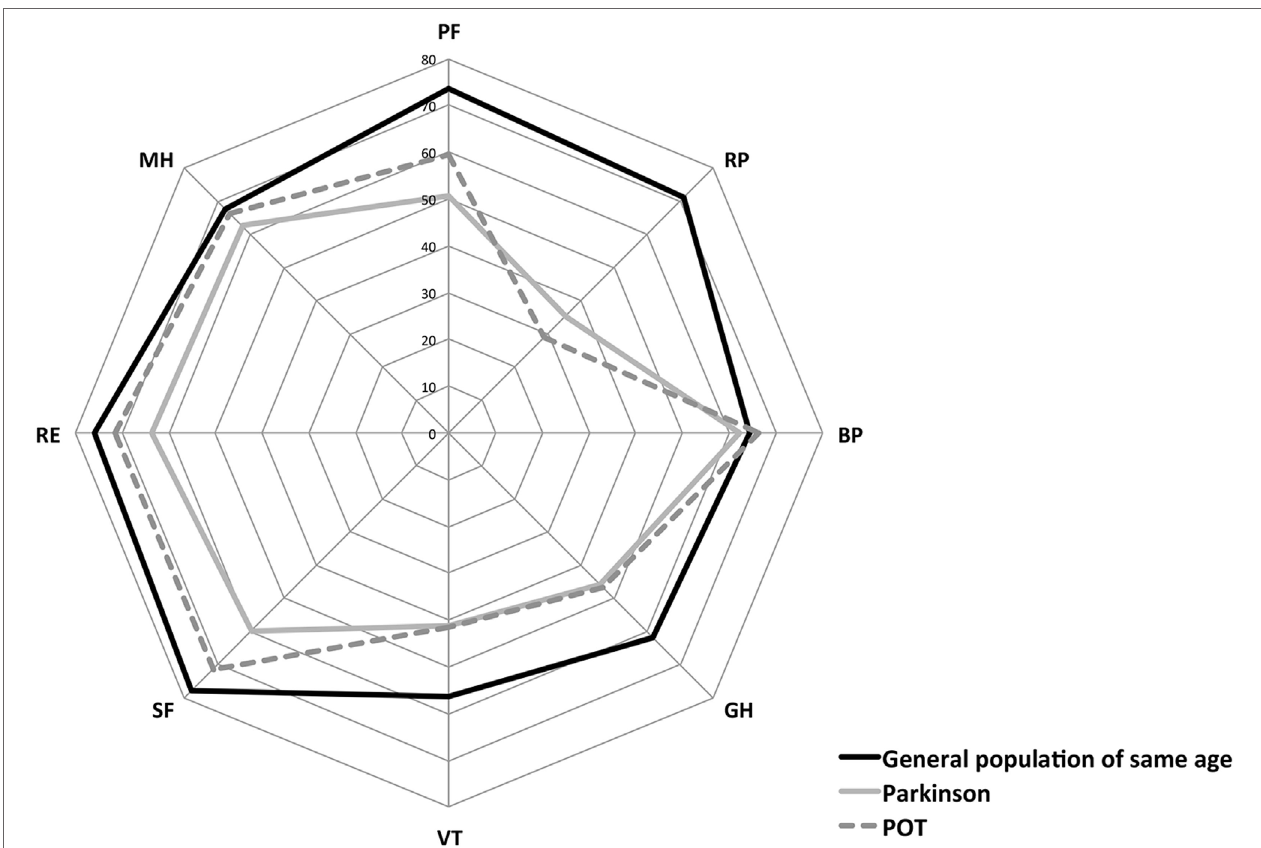
FigUre 1 | Comparison of health-related quality of life of Primary Orthostatic Tremor (POT), patients with age-matched healthy subjects and patients with Parkinson’s disease. Values are shown for each dimension using chart polar plots: physical functioning (PF), role limited by physical problems (RP), bodily pain (BP), general health (GH), vitality (VT), social functioning (SF), role limited by emotional problems (RE), and mental health (MH). SF-36, the short-form (36) health survey; POT, primary orthostatic tremor.